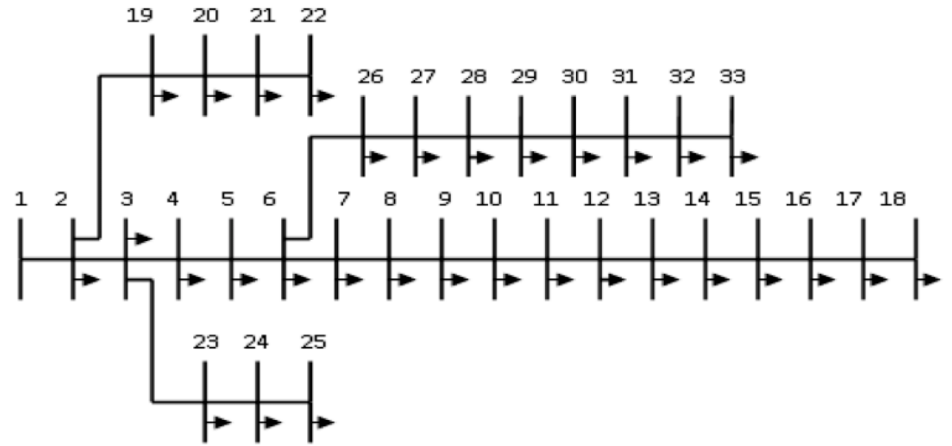
Figure 7. IEEE 33-bus radial distribution system.